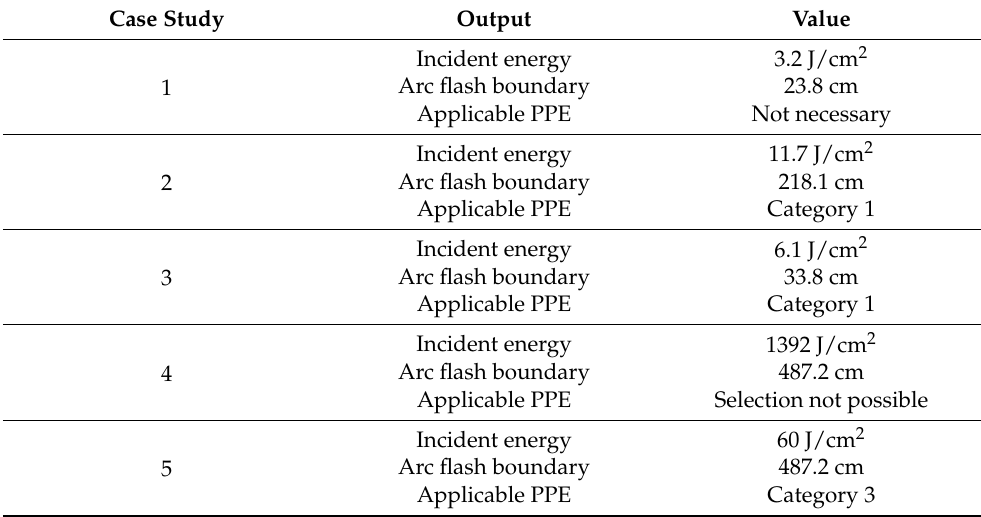
Table 12. ArcPro simulation results summary—All case